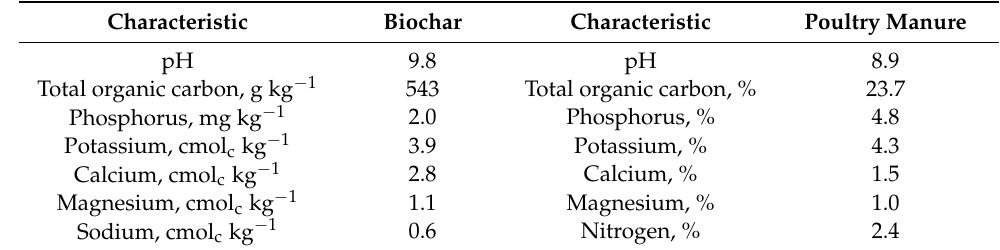
Table 2. Selected chemical characteristics of the biochar and poultry manure used in the experiment. Characteristic Biochar Characteristic Poultry Manure pH 9.8